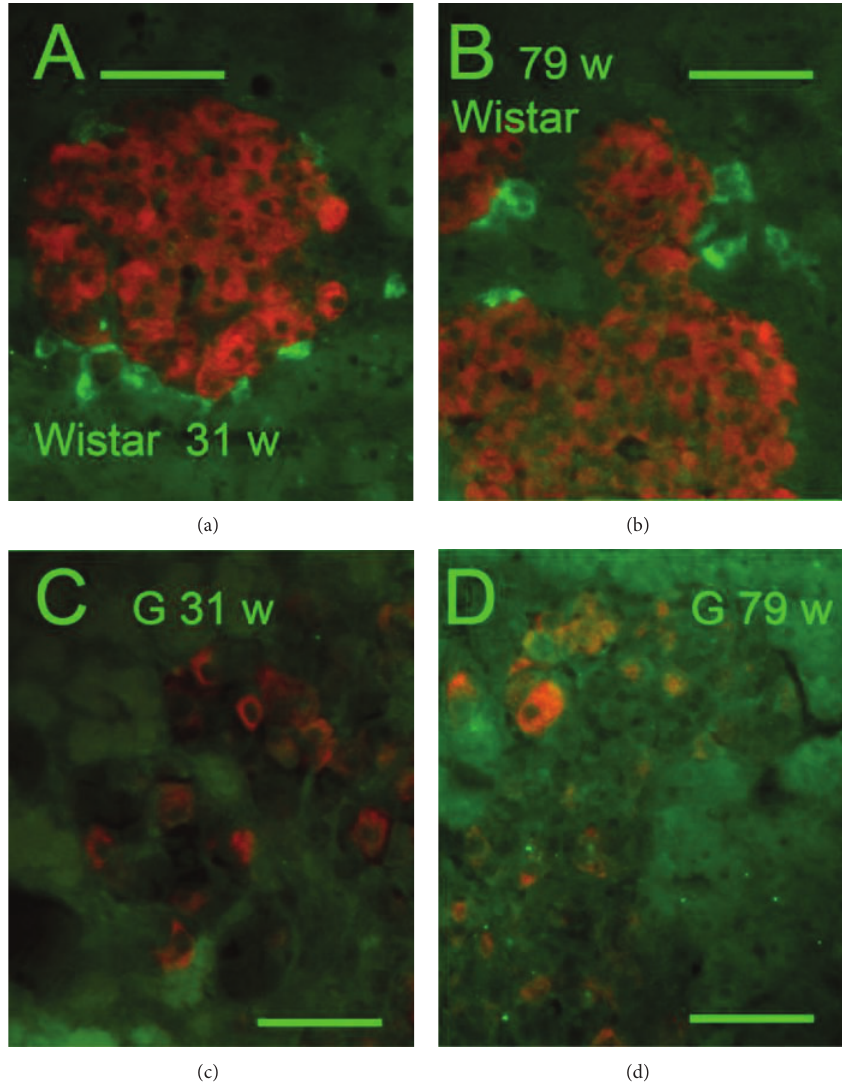
Figure 7: Insulin and PPY immunohistochemical pattern of islets. Insulin : red , PPY : green , and “ w ”: weeks . Overlay images of PI of Wistar (a, b) and Goto-Kakizaki rats (c, d). Common pattern of PPY positive cells was observed in Wistar controls of both ages of 31 (a) and 79 weeks (b). In GK, no PPY positive cells were seen in both ages of 31 (c) and 79 weeks (d). Original magnification 600x; scale bars 50 𝜇